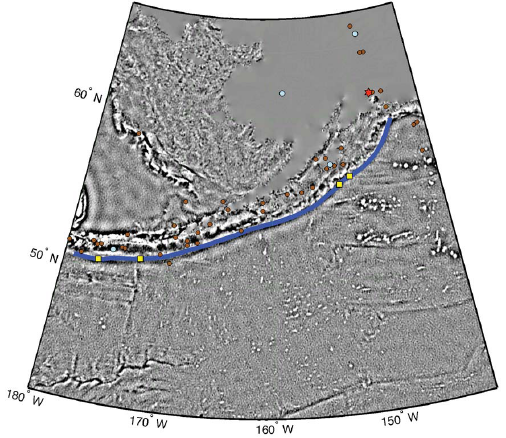
Fig. B5. Tectonic setting and key data for the Alaskan region. See Fig. B1 for legend.